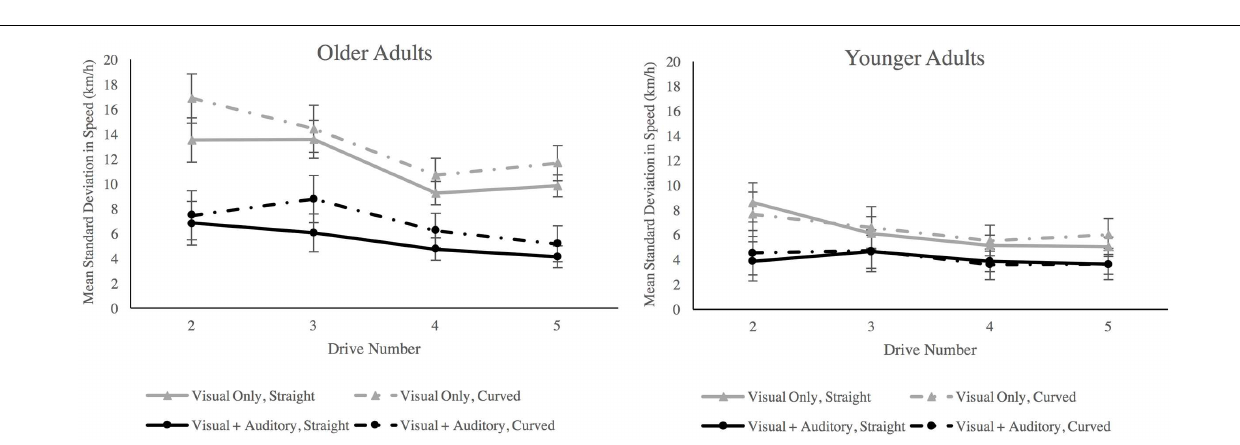
FIGURE 4 | Standard deviation in speed separated by age group, sensory condition, road geometry and drive number. Error bars are + 1SE. There was an age × sensory condition interaction in which older adults exhibited less variability in speed when both visual and auditory inputs were available compared to when only visual inputs were available. Note also main effects of age group and of sensory